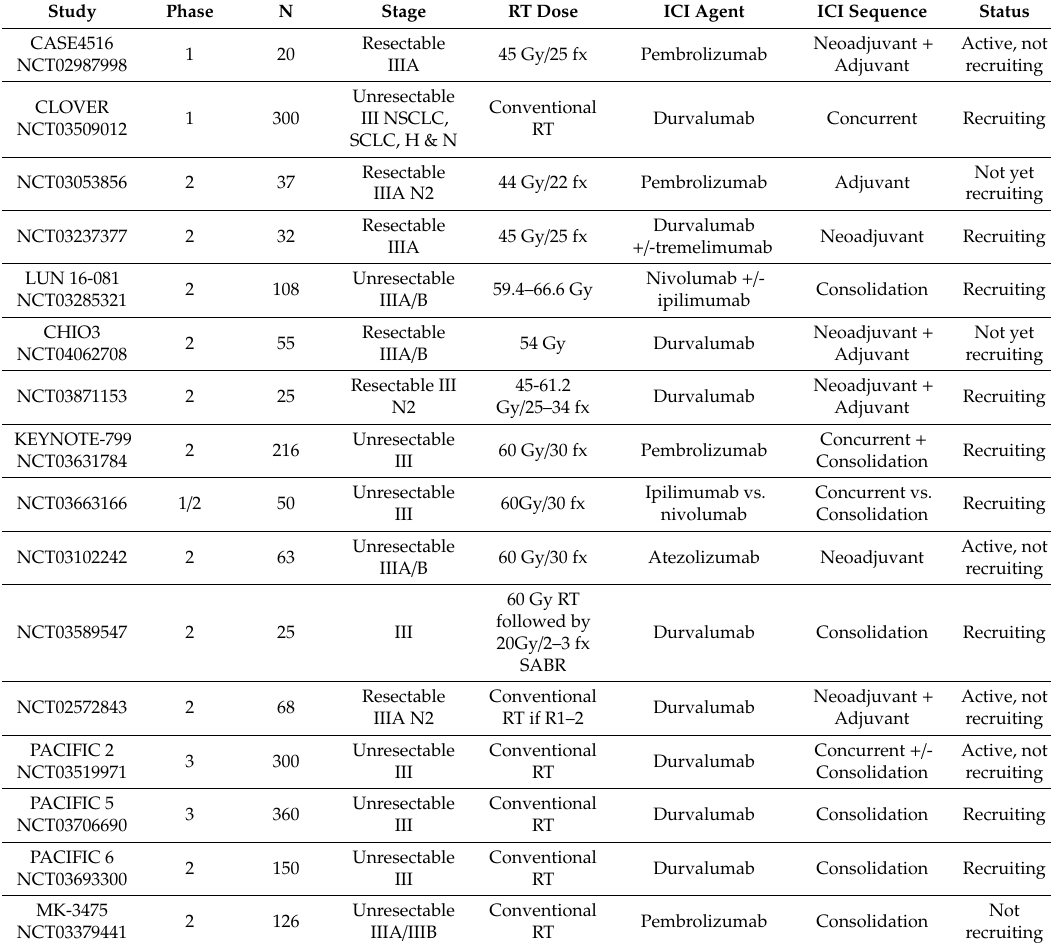
Table 5. Ongoing clinical trials evaluating the combination of ICI and RT in stage III NSCLC